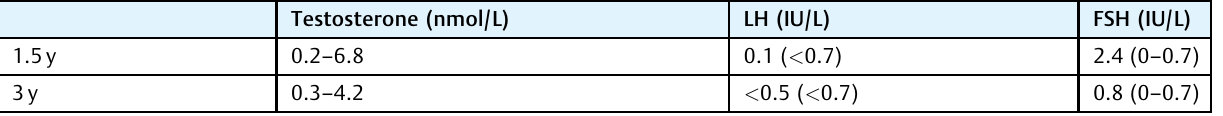
Table 1 Hcg test responses and gonadotropins levels at 1.5 and 3 years of age